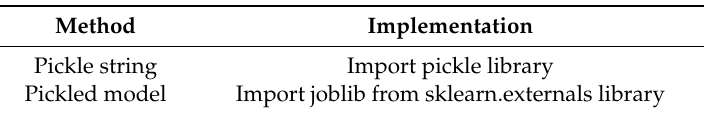
Table 8. LSTM model store